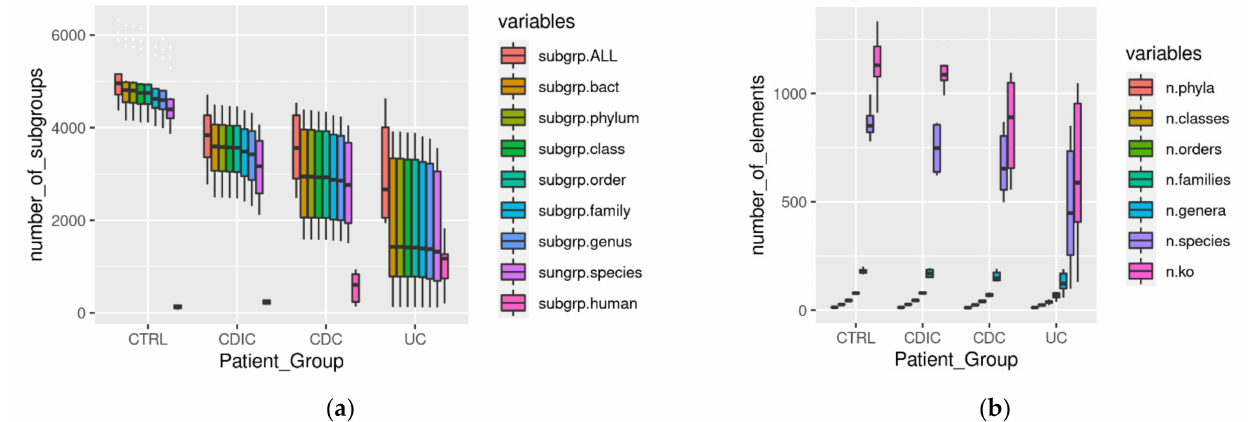
Figure 2. ( a ) Protein subgroups (abbreviated ‘subgrp’) per sample in each clinical group: subgr.ALL: total number of protein subgroups; subgrp.bact: total number of bacterial subgroups; subgrp.phylum to subgrp.species: total number of bacterial subgroups with consensual taxonomic annotation of all their protein elements from the phylum-to-species level; subgrp.ko: number of bacterial subgroups with consensual functional annotation of all their protein elements; subgrp.human: total number of human subgroups. ( b ) n.phyla to n.species: number of phyla, classes, . . . species per sample (only taxonomic annotations concordant within a same protein subgroup were counted); n.ko: number of KO entries per ample (only functional annotations concordant within a same protein subgroup were counted). Abbreviations and headcounts of patient groups are those detailed in legend of Figure